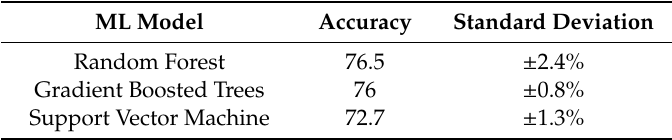
Table 4. Overall accuracy of attempted machine learning (ML) models.